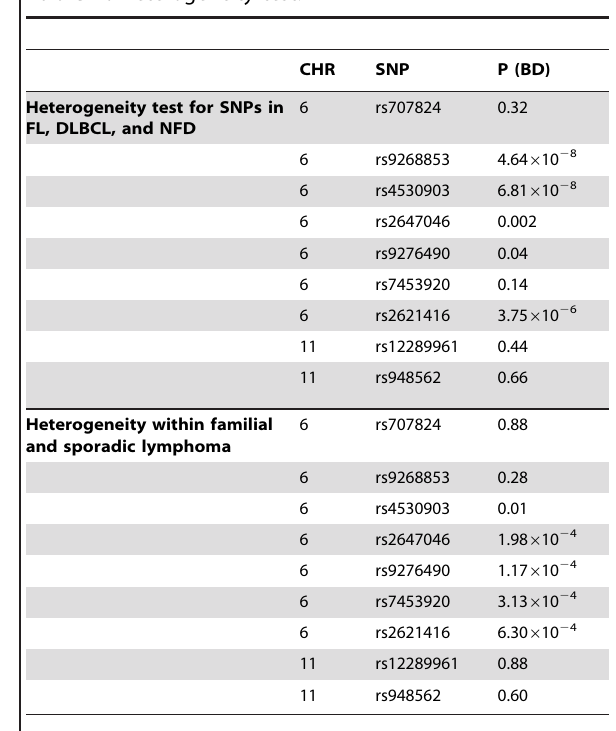
Table 2. Heterogeneity